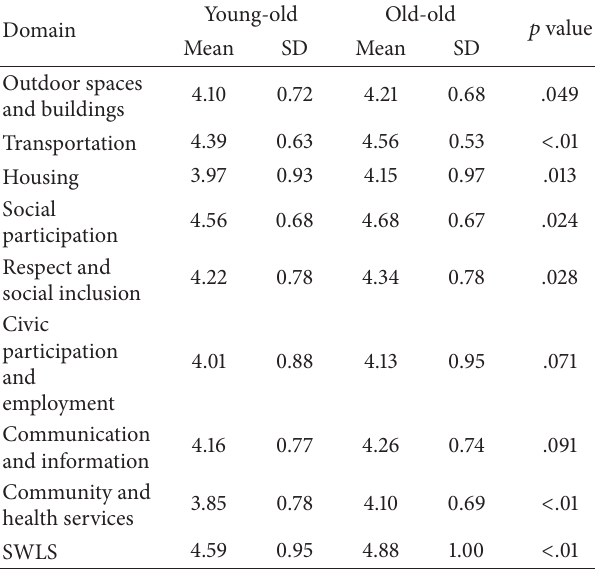
Table 2: Mean scores of age-friendly city domains and satisfaction with Life Scale of young-old and old-old